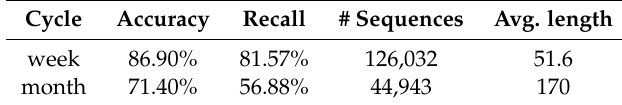
Figure 3. Accuracy and recall of the SPC model with the impact of different sequence lengths. Table 11. The comparison result of different